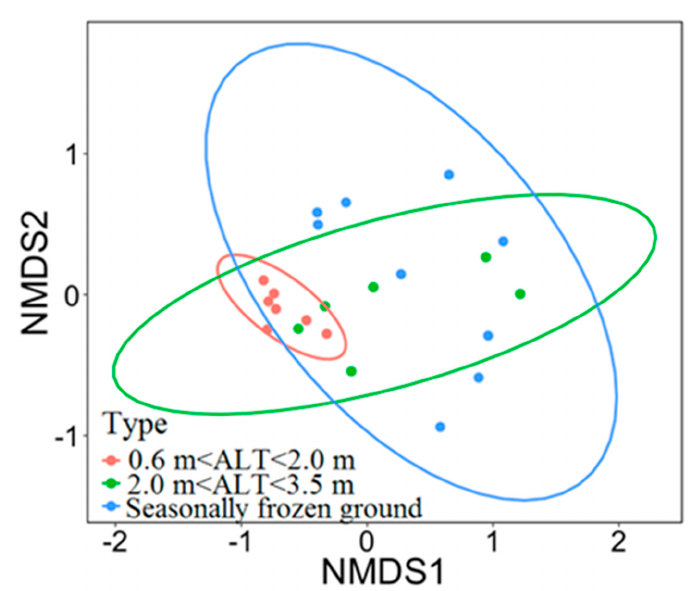
Figure 4. Non-metric multidimensional (NMDS) plot for the vegetation composition. The sites were divided into three categories based on their active layer thickness (ALT) at permafrost sites and at sites in areas of seasonally frozen ground (k = 2, stress = 0.15). Lines are standard dispersion ellipses, showing 95% confidence interval.